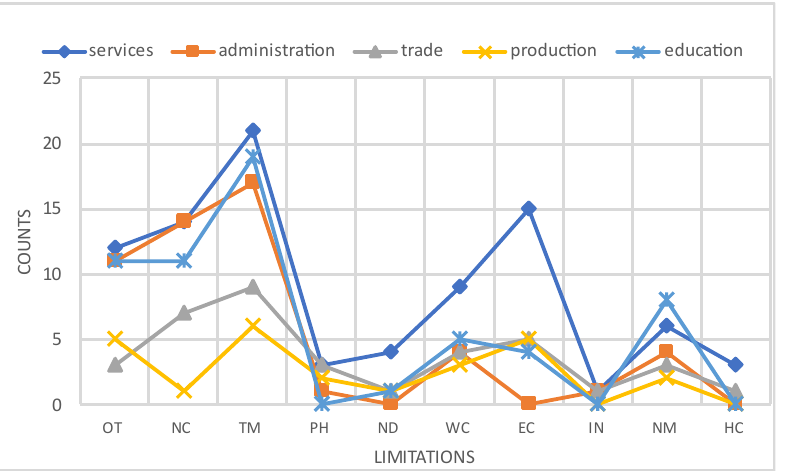
Figure 31. A graph of interactions between limitations in the availability of tram transport and industry.